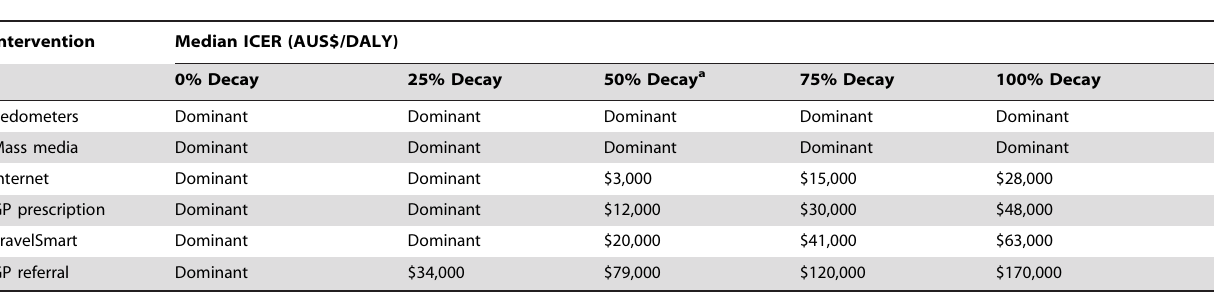
Table 6. Sensitivity of the median ICERs to the rate of decay in intervention health effects.